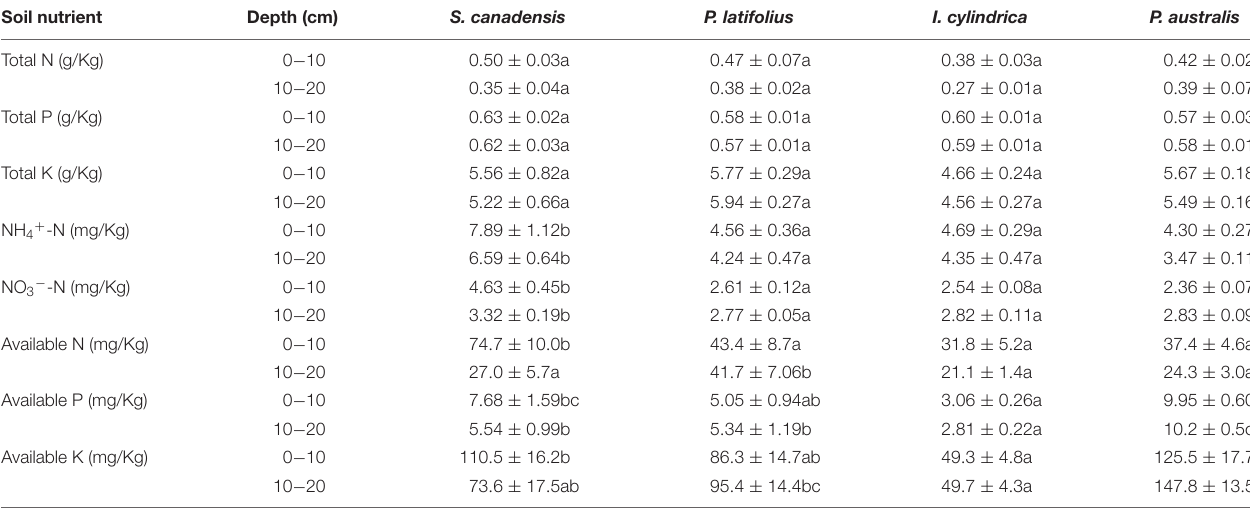
TABLE 3 | N, P, and K concentrations at the two soil depths in the community dominated by each of the four plant species. Soil nutrient Depth (cm) S.